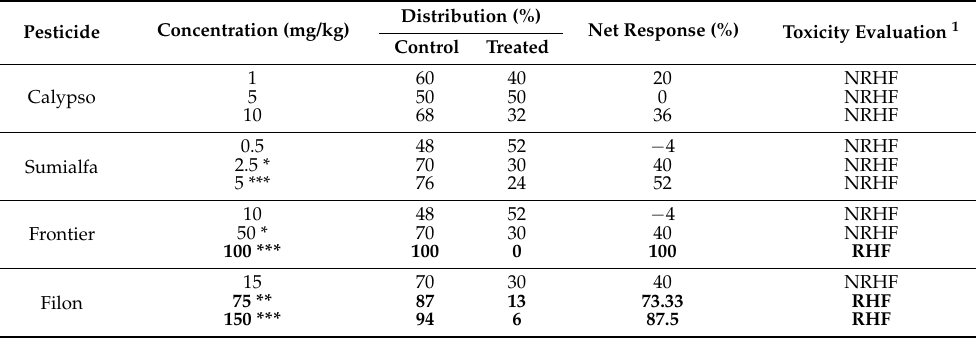
Table 2. Effect of commercial pesticide preparations on the avoidance behavior of E. andrei in soil— 48 h exposures to the respective commercial pesticide preparations and controls in LUFA 2.2 soil for the determination of avoidance behavior. * p < 0.05, ** p < 0.01, and *** p < 0.001. Distribution (%) Net Response (%) Toxicity Evaluation 1 Pesticide Concentration (mg/kg) Control